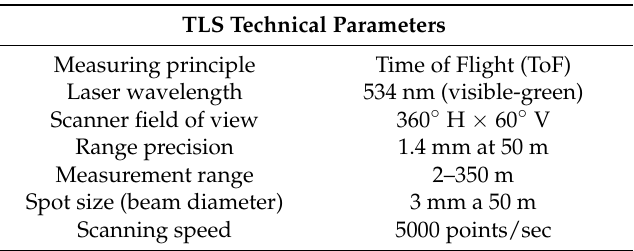
Table 2. Technical specifications of the Trimble GX laser scanner.